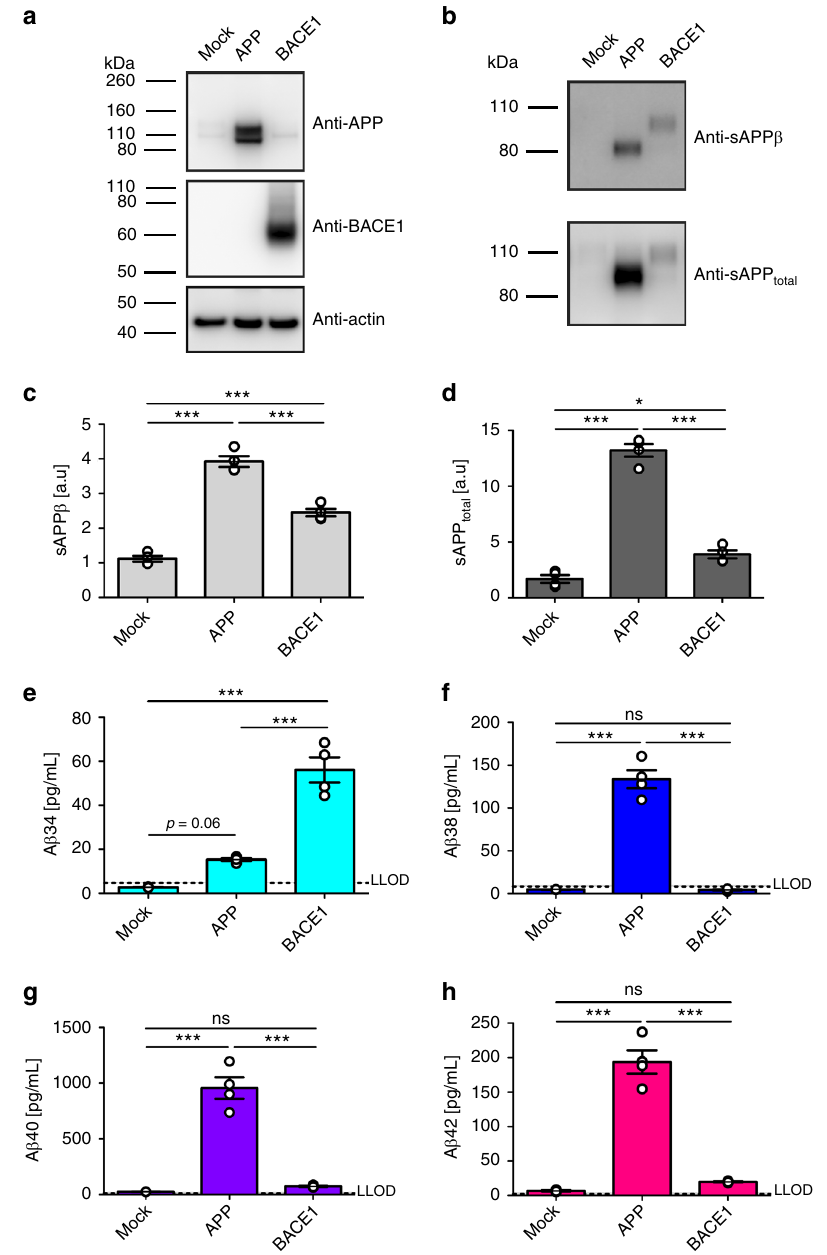
Fig. 3 Surplus of APP or BACE1 differentially affect APP processing. Using SH-SY5Y cells stably expressing APP695 or BACE1, cleavage of APP was analyzed by western blot and ultra-sensitive MSD assay. Representative western blots for the examination of APP, BACE1, sAPP β , and sAPP total ( a , b ), and the corresponding quanti fi cation for the relative amounts of sAPP β ( c ) and sAPP total ( d ). MSD multiplexing to quantify the absolute amounts of A β 34 ( e ), A β 38 ( f ), A β 40 ( g ), and A β 42 ( h ). Data were collected from four independent experiments. Bars and error bars indicate mean ± s.e.m. c – h Data were analyzed with one-way ANOVAs and Tukey ’ s post-hoc tests were performed for pairwise comparisons; selected comparisons are highlighted *** p < 0.001, * p < 0.05, ns = nonsigni fi cant p > 0.05. c sAPP β , F (2, 9) = 131.2, p < 0.0001, d sAPP total , F (2, 9) = 190.3, p < 0.0001, e A β 34, F (2, 9) = 70.04, p < 0.0001, f A β 38, F (2, 9) = 149.0, p < 0.0001, g A β 40, F (2, 9) = 89.96, p < 0.0001, h A β 42, F (2, 9) = 113.6, p < Fig. 4). Conditioned medium from APP-overexpressing SH-SY5Y human neuronal cell line, resulting in (i) increased A β 38, A β 40, cells showed signi fi cantly decreased levels of sAPP β , A β 34, A β 38, and A β 42 release from APP-overexpressing cells, or (ii) an A β 40, and A β 42 in the presence of MK-8931 (Fig. 4a – d, enhanced degradation of all longer A β forms into A β 34 in Supplementary Fig. 4a – c). Furthermore, a dose-inhibition curve for MK-8931 was performed and sAPP β (western blot), A β 34 (MSD 1-plex), and A β 40 (MSD 1-plex) were measured (Supplementary Fig. 4d – f). In APP-overexpressing SH-SY5Y cells, MK-8931 dose-dependently decreased sAPP β (pIC 50 = 10.7 ± 0.3 (s.e.m.)), A β 34 (pIC 50 = 14.1 ± 0.6), and A β 40 levels